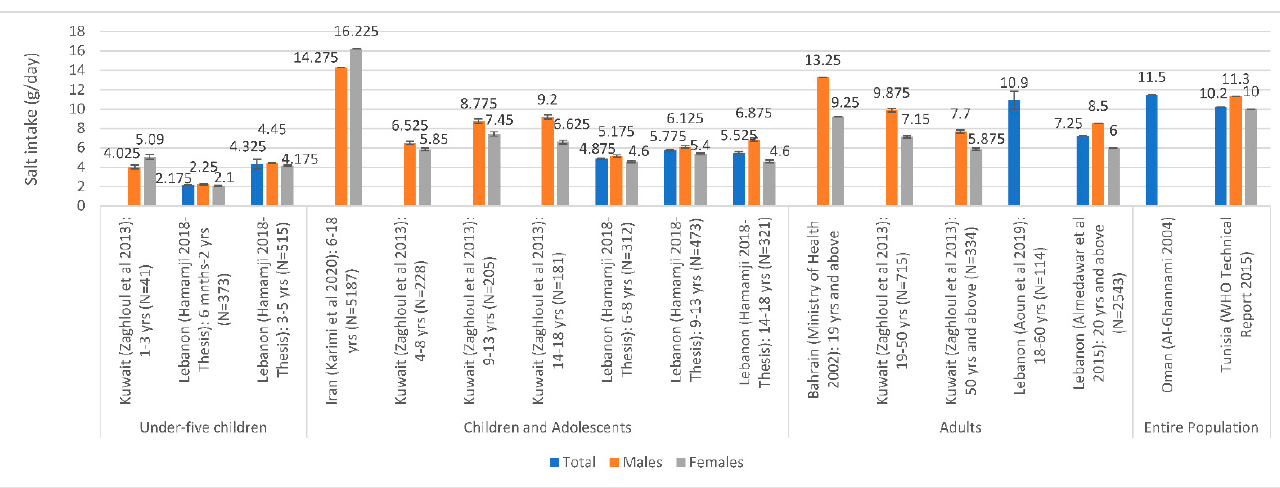
Figure 3. Salt intake estimates based on national dietary assessment studies conducted in countries of the EMR#. Abbre- viations: EMR: Eastern Mediterranean Region; WHO: World Health Organization. References: For Underfive Children: Kuwait: Zaghloul et al., 2013 [59]; Lebanon: Hamamji 2018–Thesis [67]. For Children and Adolescents: Iran: Karimi et al., 2020 [45]; Kuwait: Zaghloul et al., 2013 [59]; Lebanon: Hamamji 2018–Thesis [67]. For Adults: Bahrain: Ministry of Health 2002 [25]; Kuwait: Zaghloul et al., 2013 [59]; Lebanon: Aoun et al., 2019 [68] and Almedawar et al., 2015 [69]. For the Entire Population: Oman: Al-Ghannami 2004 [77]; Tunisia: WHO Technical Report 2015 [84]. #: Error bars (standard deviations around the mean) are presented, when available.